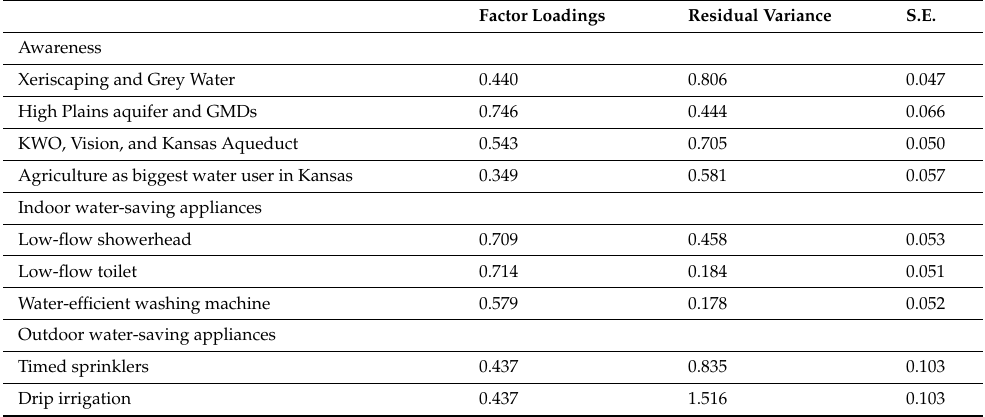
Table A3. Standardized model results of owning water-saving appliances for appliances for indoor and outdoor usage regressed on awareness levels for well owners (n = 407).